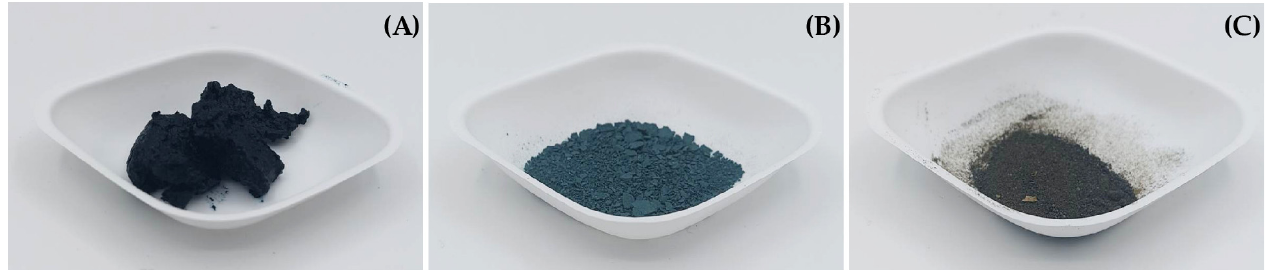
Figure 1. The appearance of A. platensis biomass residues: ( A ) the biomass residue after PC extraction; ( B ) F-DBR; and ( C ) HAO-DBR.